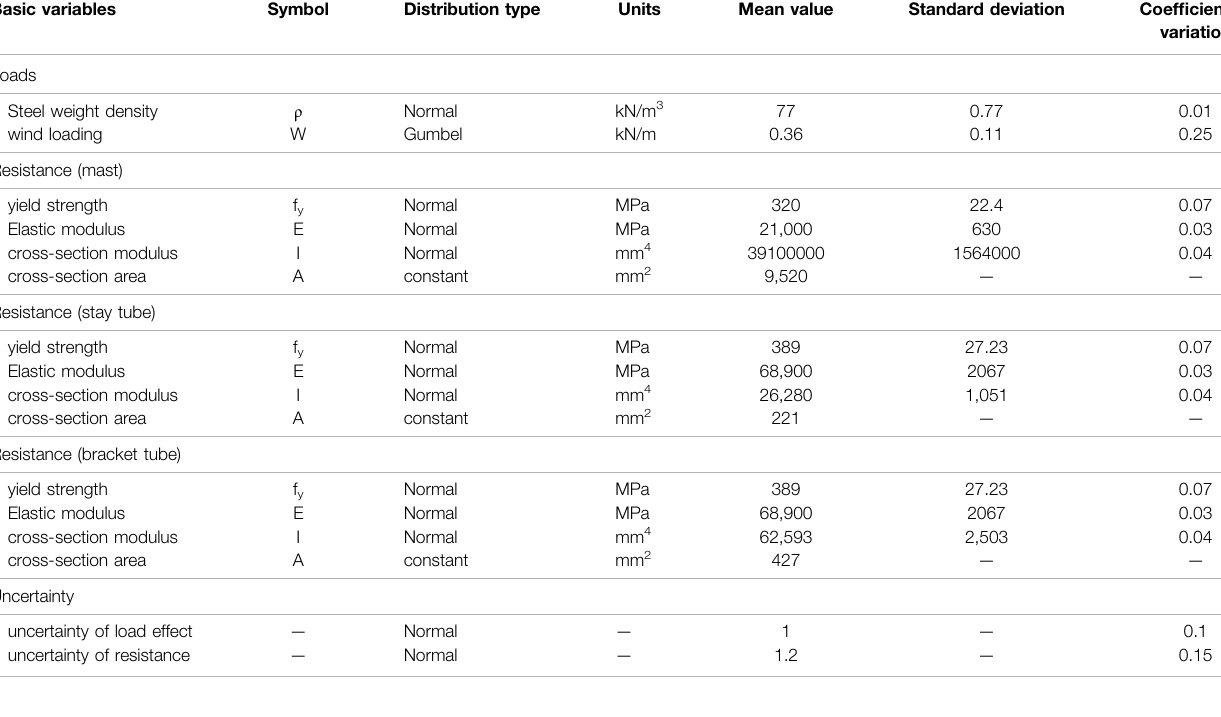
TABLE 4 | Statistical model of the selected mast structure (JCSS, 2000).